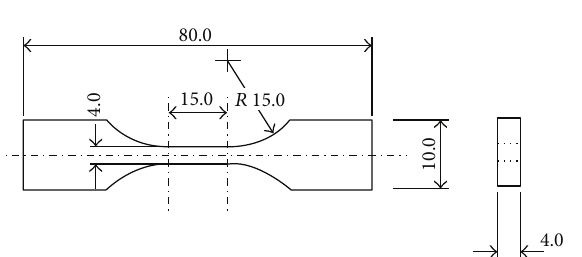
Figure 2: Geometry of the tensile test specimen used in this investigation according to ASTM D882.